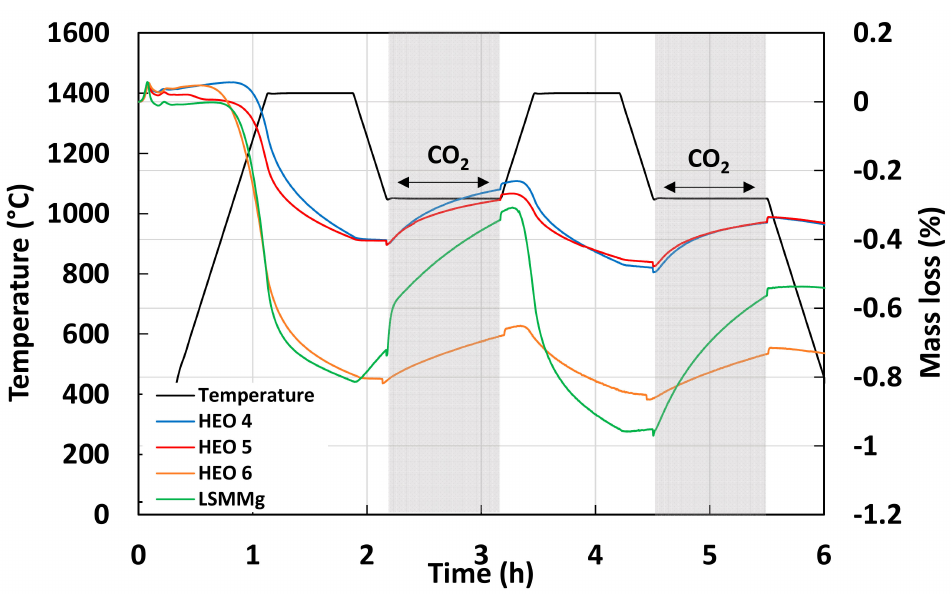
Figure 11. Thermogravimetric analysis of two consecutive CO 2 -splitting cycles with HEO 4, HEO 5 and HEO 6 in comparison with (La 0.5 Sr 0.5 )Mn 0.9 Mg 0.1 O 3 .